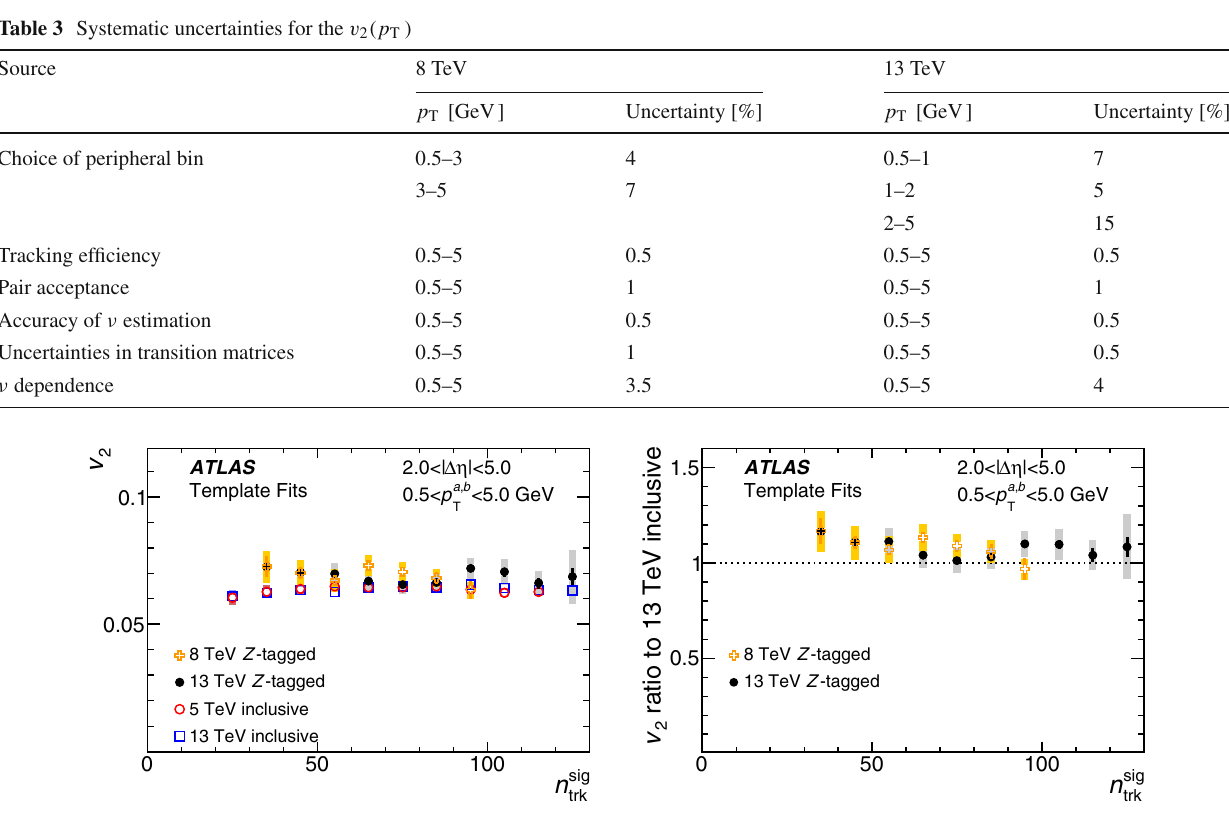
respectively. Right panel: the ratio of the v 2 in 8 and 13 TeV Z -tagged samples to the v 2 in inclusive 13 TeV pp collisions as a function of n sig . trk The horizontal dotted line indicates unity and is intended to guide the < 5 eye. Results are ploted for 0 . 5 < p a , b T